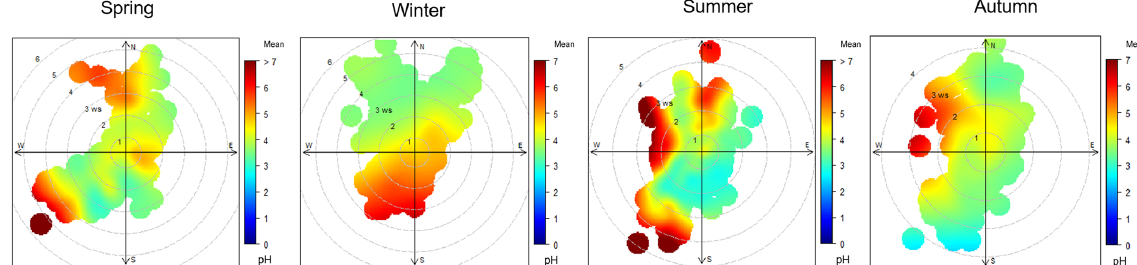
Figure 5. Wind-dependence map of PM 2 . 5 pH over four seasons. In each picture, the shaded contour indicates the mean value of PM 2 . 5 pH for varying wind speeds (radial direction) and wind directions (transverse direction) (data at RH ≤ 30% were excluded).